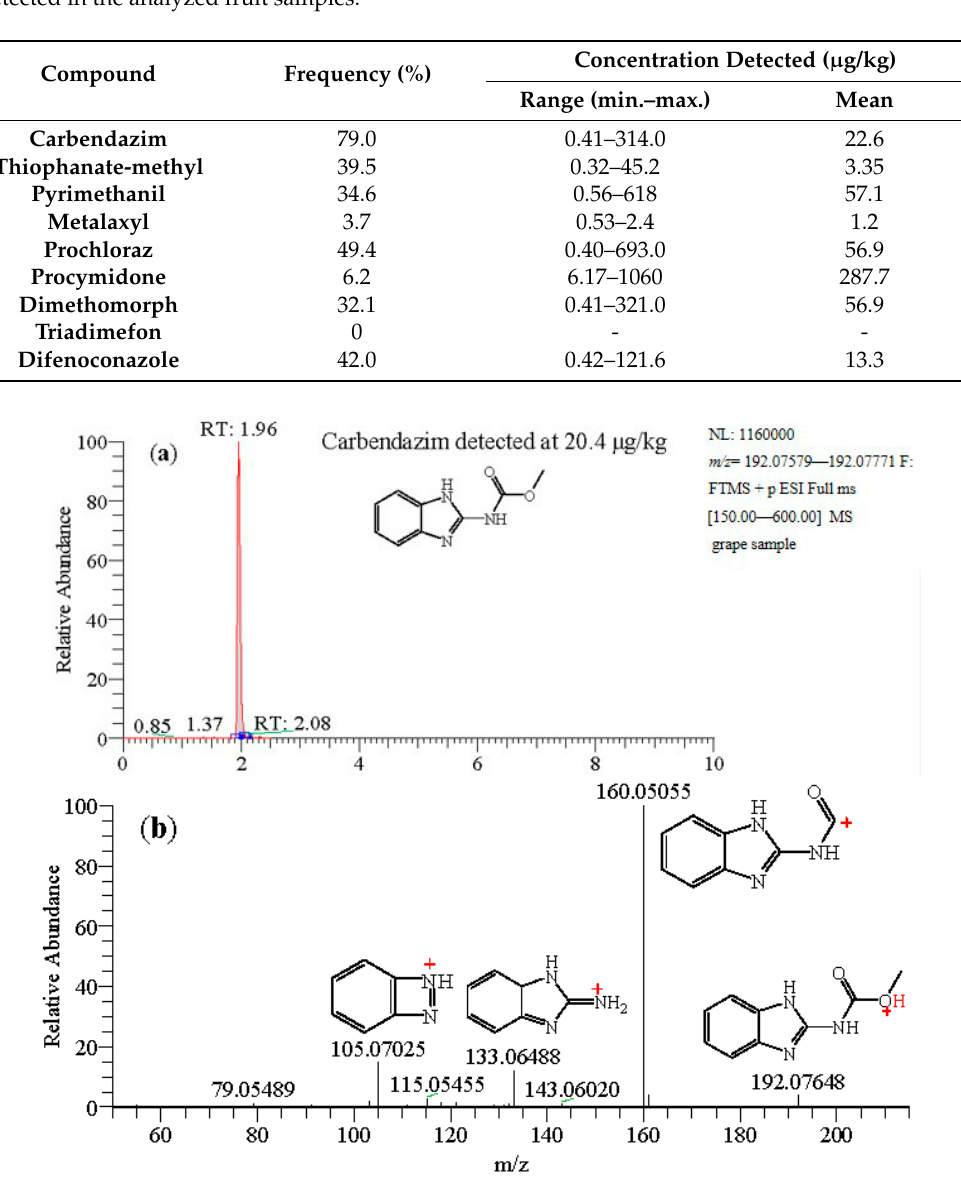
Table 5. Frequency, mean, minimum (min.), and maximum (max.) levels of the nine target fungicides detected in the analyzed fruit samples.